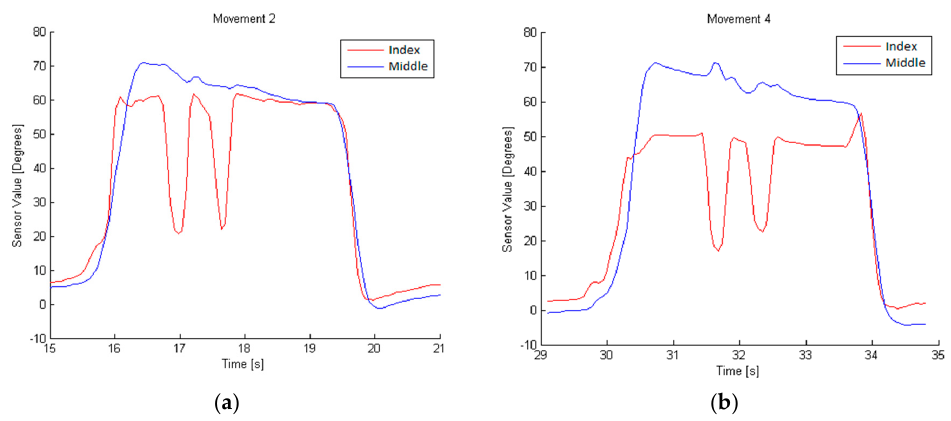
Figure 6. ( a ) Sensor values during movement 2 and ( b ) movement 4, performed by the same person. Movement 1 can be identified by analyzing the data from the index and middle fingers. Each rise and fall in the glove sensor values corresponds to the flexion and extension movements of the fingers. This movement consists of a descent (called D1) and ascent (A1), followed by another descent (D2) and ascent (A2), as shown in Figure 7. This is the flexion pattern considered for movement 1. The D time and A time are, respectively, the times taken during a descent or ascent.